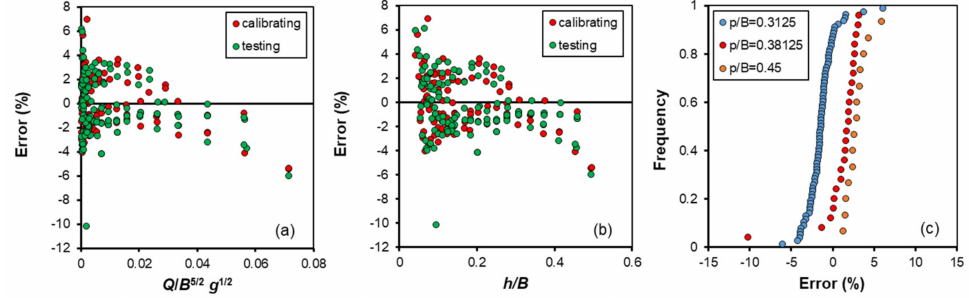
Figure 6. Relationships between the errors Er in the discharge estimate obtained by Equation (22) and the main characteristics of the investigated data Q / B 5/2 g 1/2 ( a ), h / B ( b ), and p / B ( c